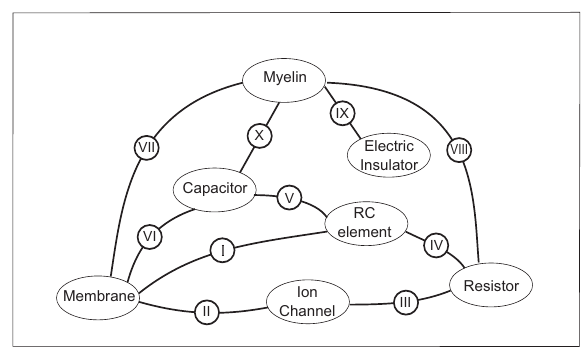
FIG. 7. A concept map, representative for the level of knowl- edge of the treatment group. The propositions are labeled down- ward according to their frequency of occurrence (cid:1) I–X (cid:2)